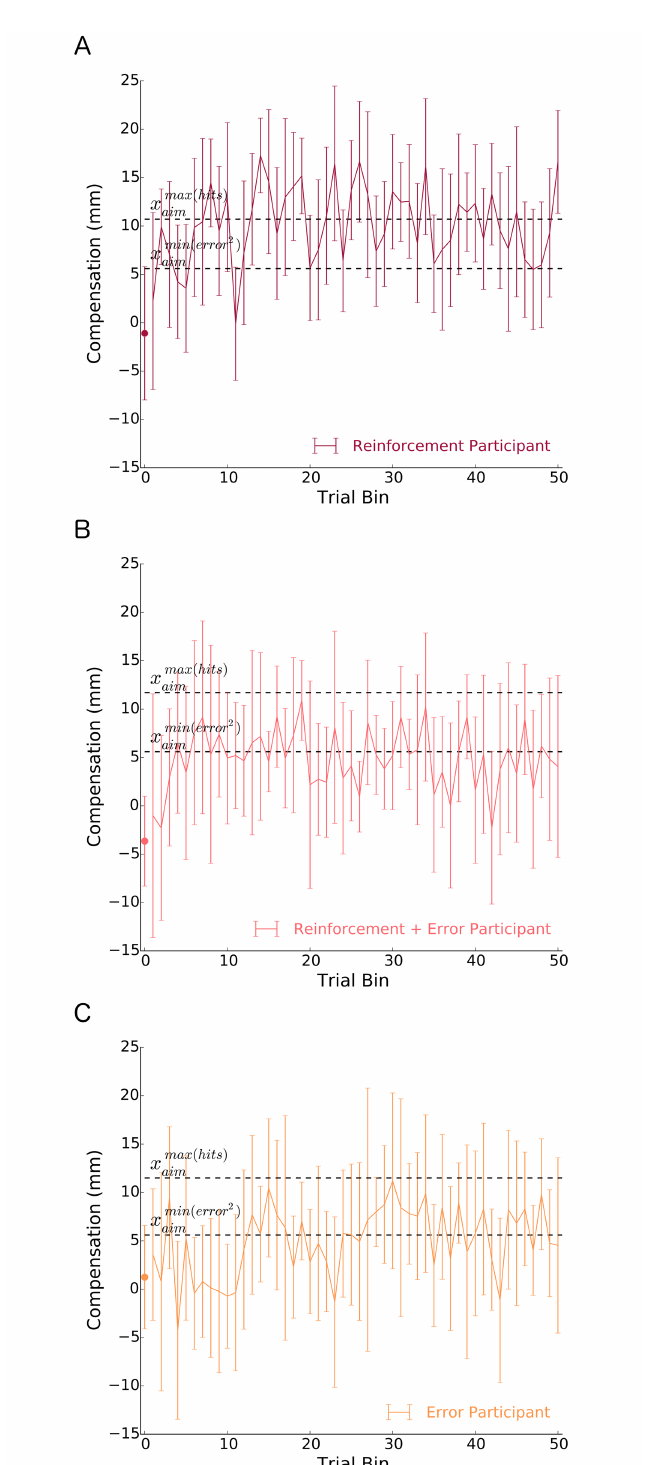
Fig 5. Pattern of compensation of a typical participant in the: A) reinforcement group, B) reinforcement + error group, and C) error group. All experimental trials are representedin the line graph (bins 1–50), where each point represents the averageof 10 trials. The circles at bin 0 represent the averageof the first three trials and show each participant’sbehaviour immediately after perturbation onset, which was similar across groups (see Fig 6). For each group, the upper dashedline represents the optimal